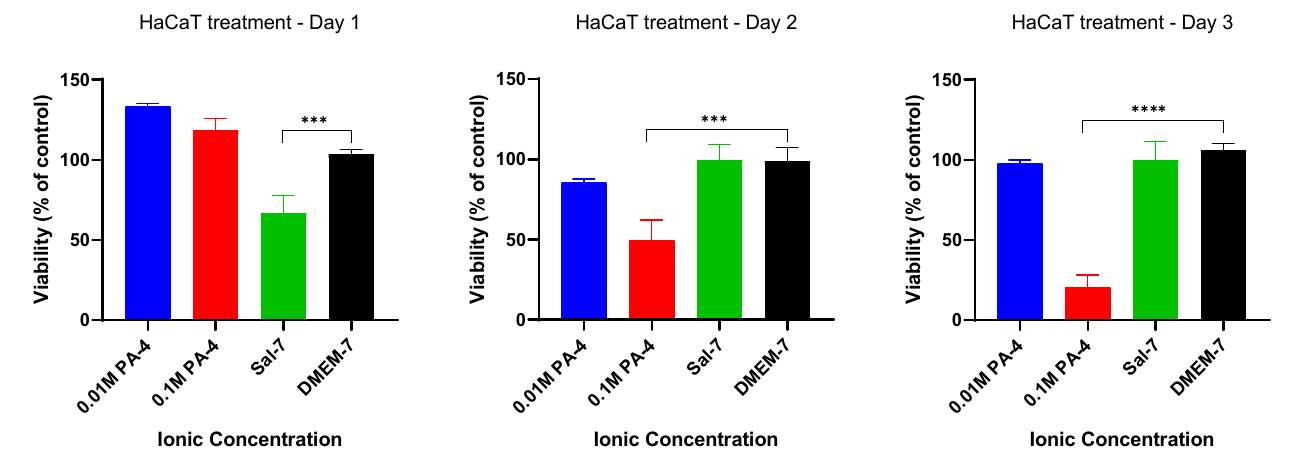
Figure 1. HaCaT cells metabolized well at low ionic strength and acid molarity of 0.01 M. The metabolism rate was significantly reduced with increased acid molarity to 0.1 M. Each bar represents the mean ± standard deviation. * p < 0.05, ** p < 0.01 , ***p < 0.005 and ****p < 0.001 indicates that the results obtained were statistically significant from those of the control group (DMEM-7).